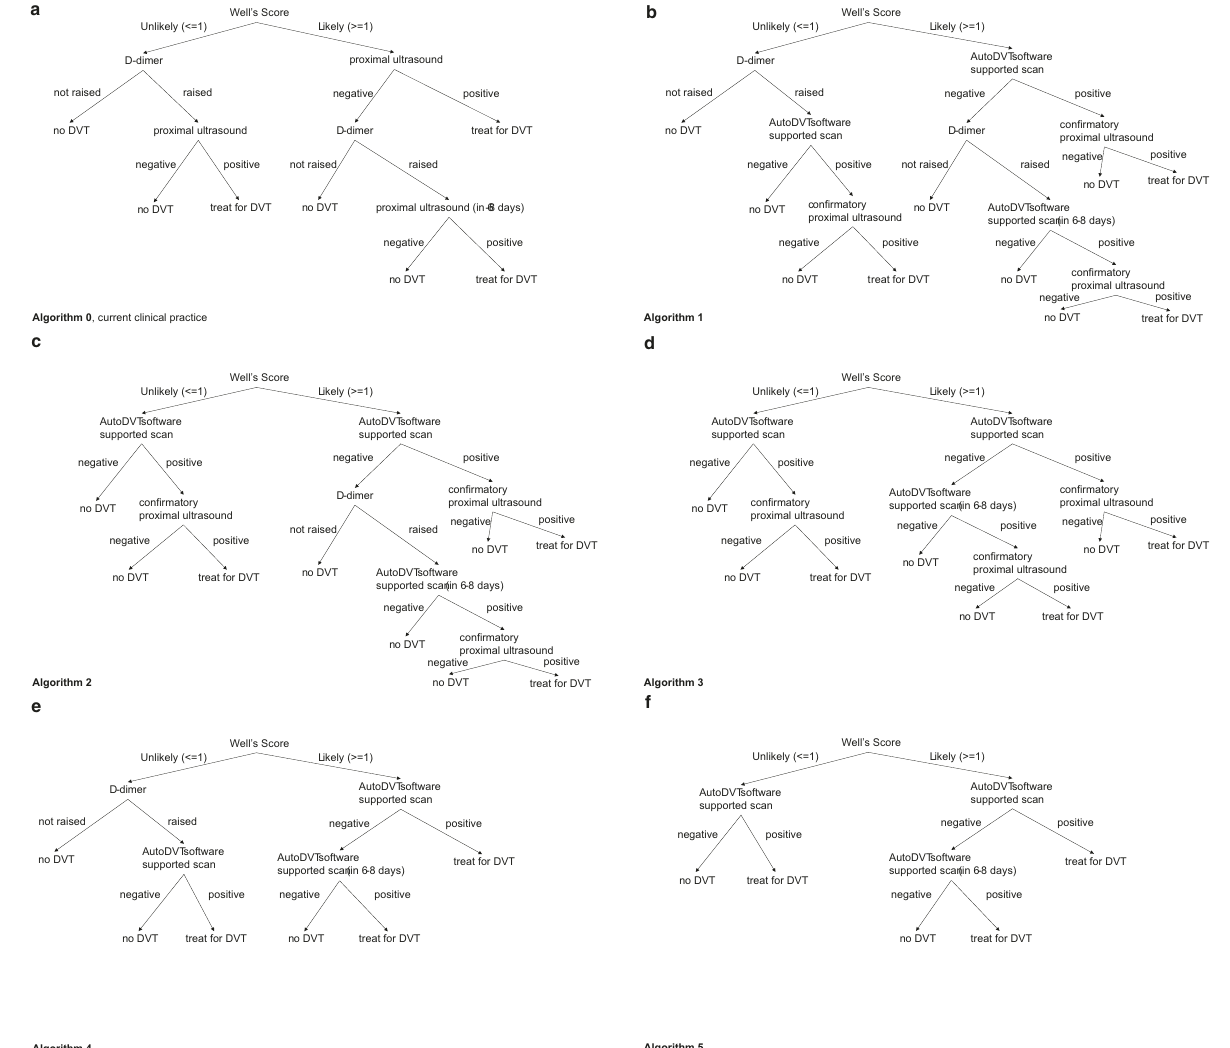
Fig. 11 Possible integration strategies for our approach into DVT diagnostics pathways. a current clinical algorithm to diagnose DVT without software support according to UK NICE guidelines 6 and b – f possible variants to integrate ML software support into the clinical pathway. Algorithms 1 – 3 shown in ( b – d ) generate a positive net monetary bene fi t (cf. Fig. 6). The examined modi fi cations have been suggested by health economics and clinical experts. Note that treatment options may further depend on the age of the clot, which might be manually estimated during con fi rmatory ultrasound scans 43